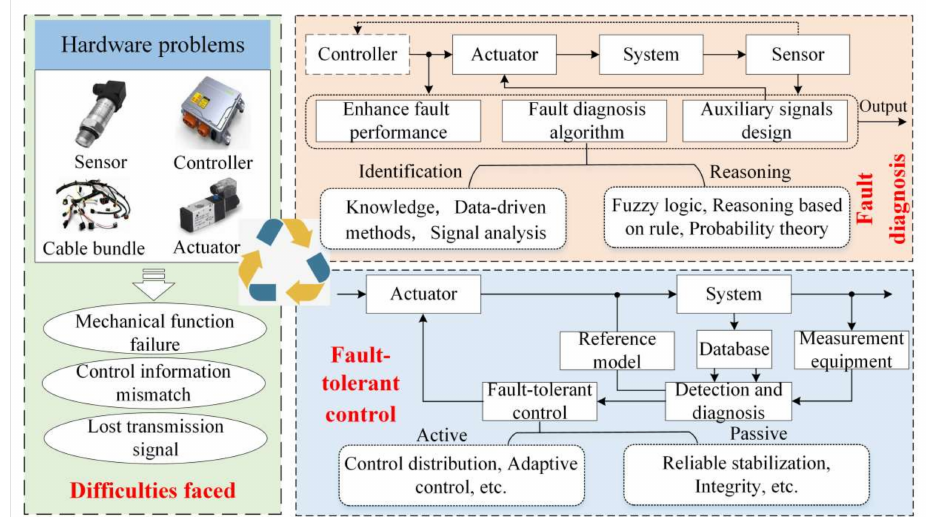
Figure 5. The characteristics and solutions of the brake